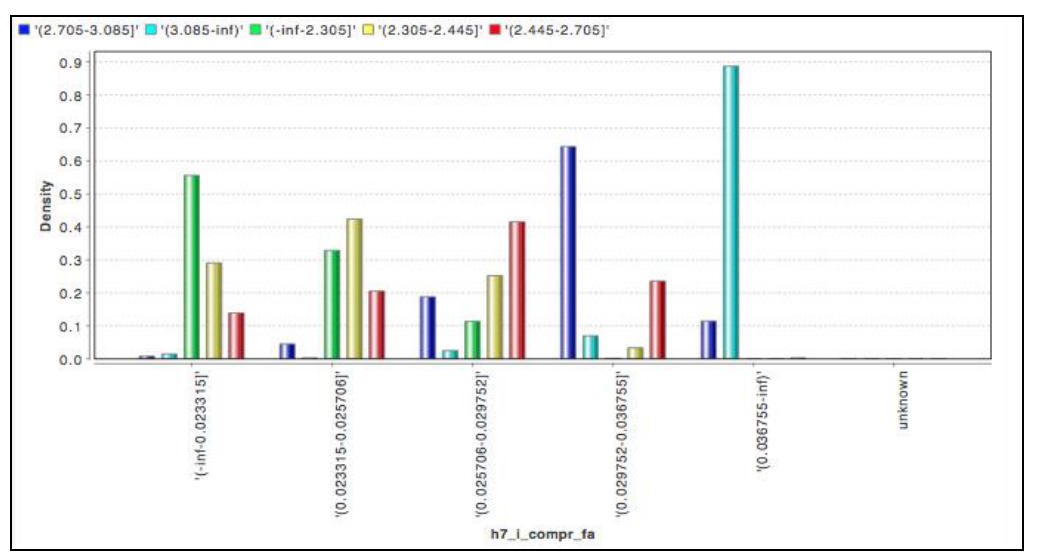
Figura 4 - Densidad de probabilidad de intervalos discretos de THDv.